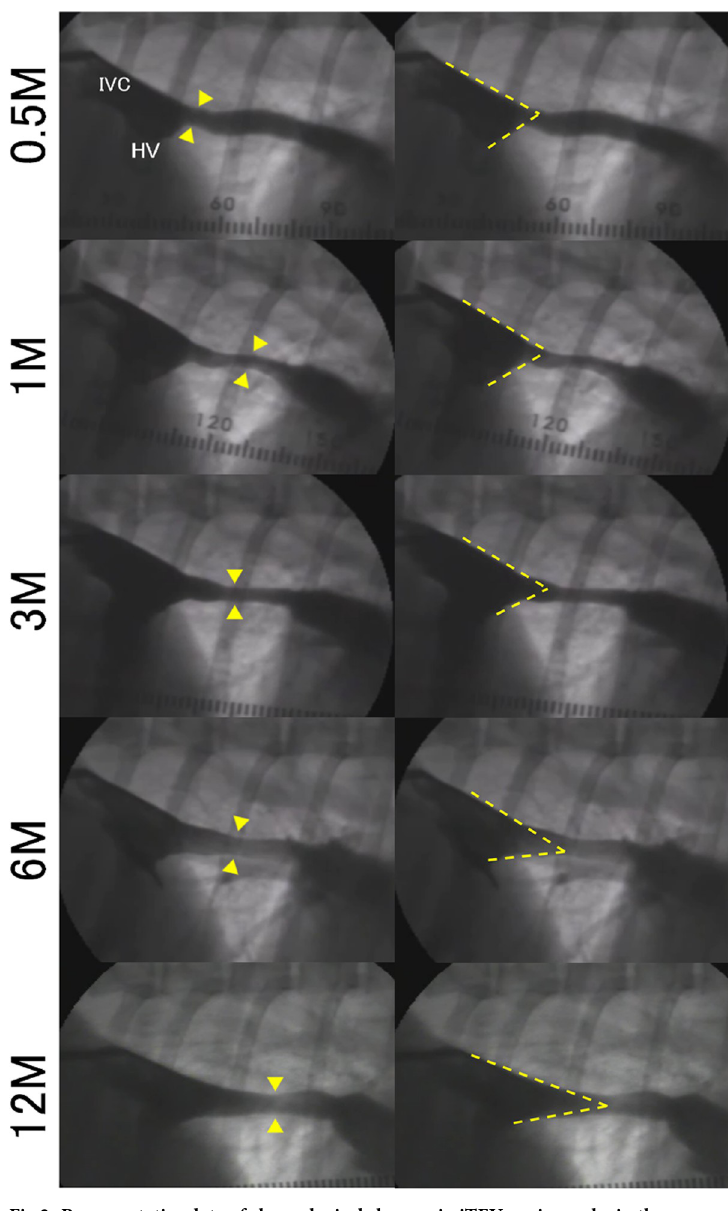
Fig 2. Representative data of chronological changes in iTEV angiography in the same sample. Left row: Yellow arrowheads indicate the site with the smallest iTEV diameter in each study. IVC: inferior vena cava, HV: hepatic vein. Right row: The angle was composed of two slanted dashed lines at the IVC–HV junction, which was measured to calculate the HV index. iTEV features, as well as native IVC, HV, and iTEV measurements change over time. triangles and short dashed lines in Fig 2, all digital data were examined to calculate the smallest iTEV diameter, and the angle of the two dashed slanted lines was used to calculate HV index. Spearman’s Rho of the least estimated area of iTEV, the IVC–HV junction angle, and HV index were − 0.695 (95% confidence interval [CI]: − 0.792, − 0.540, P < 0.001) (S2A Fig), 0.603 (95% CI: 0.40, 0.757, P < 0.001) (S2E Fig), and 0.718 (95% CI: 0.560, 0.818, P < 0.001), respec- tively (Table 1 and Fig 3A). As shown in Table 2, HV index showed a strong correlation with